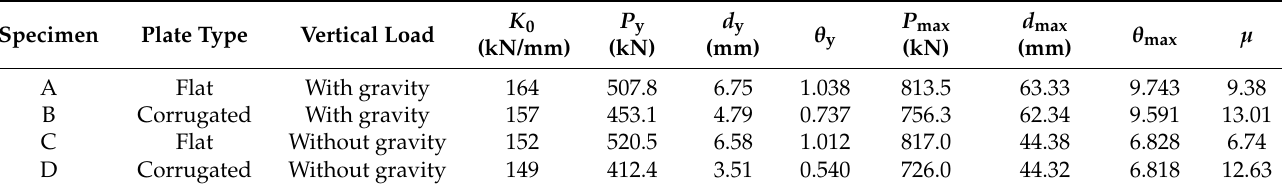
Figure 3. Envelope curves of specimens A, B, C, and D. (Adapted with permission from Ref. [22]. Copyright 2022 Springer Nature.) Table 3. Summary of test